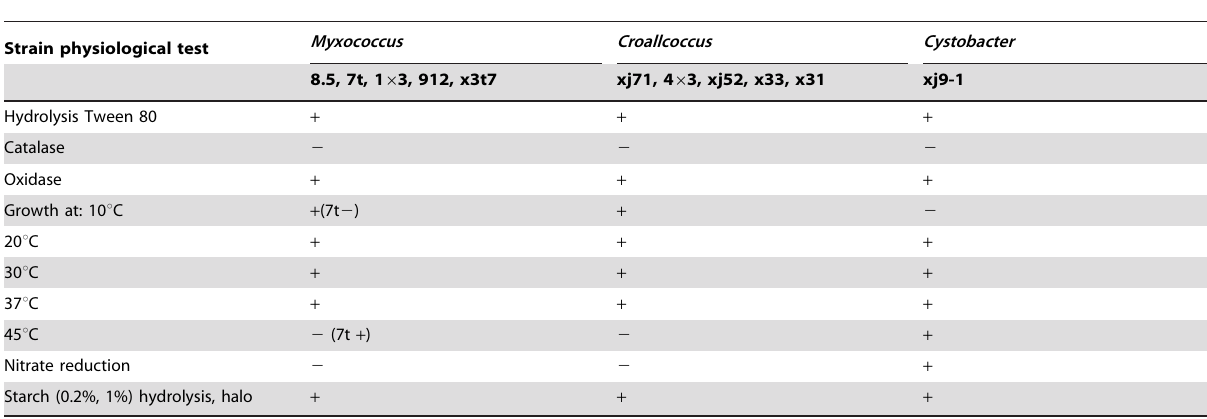
Table 5. Physiological properties of new isolates from saline-alkaline soils.